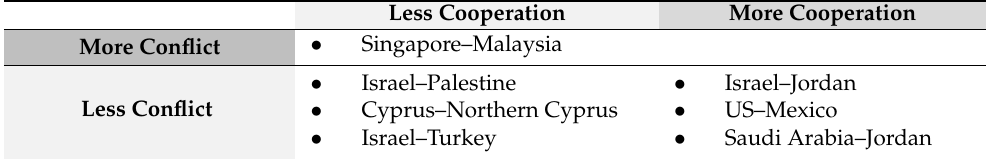
Table 7. Summary table of water interactions. Less Cooperation More Cooperation More